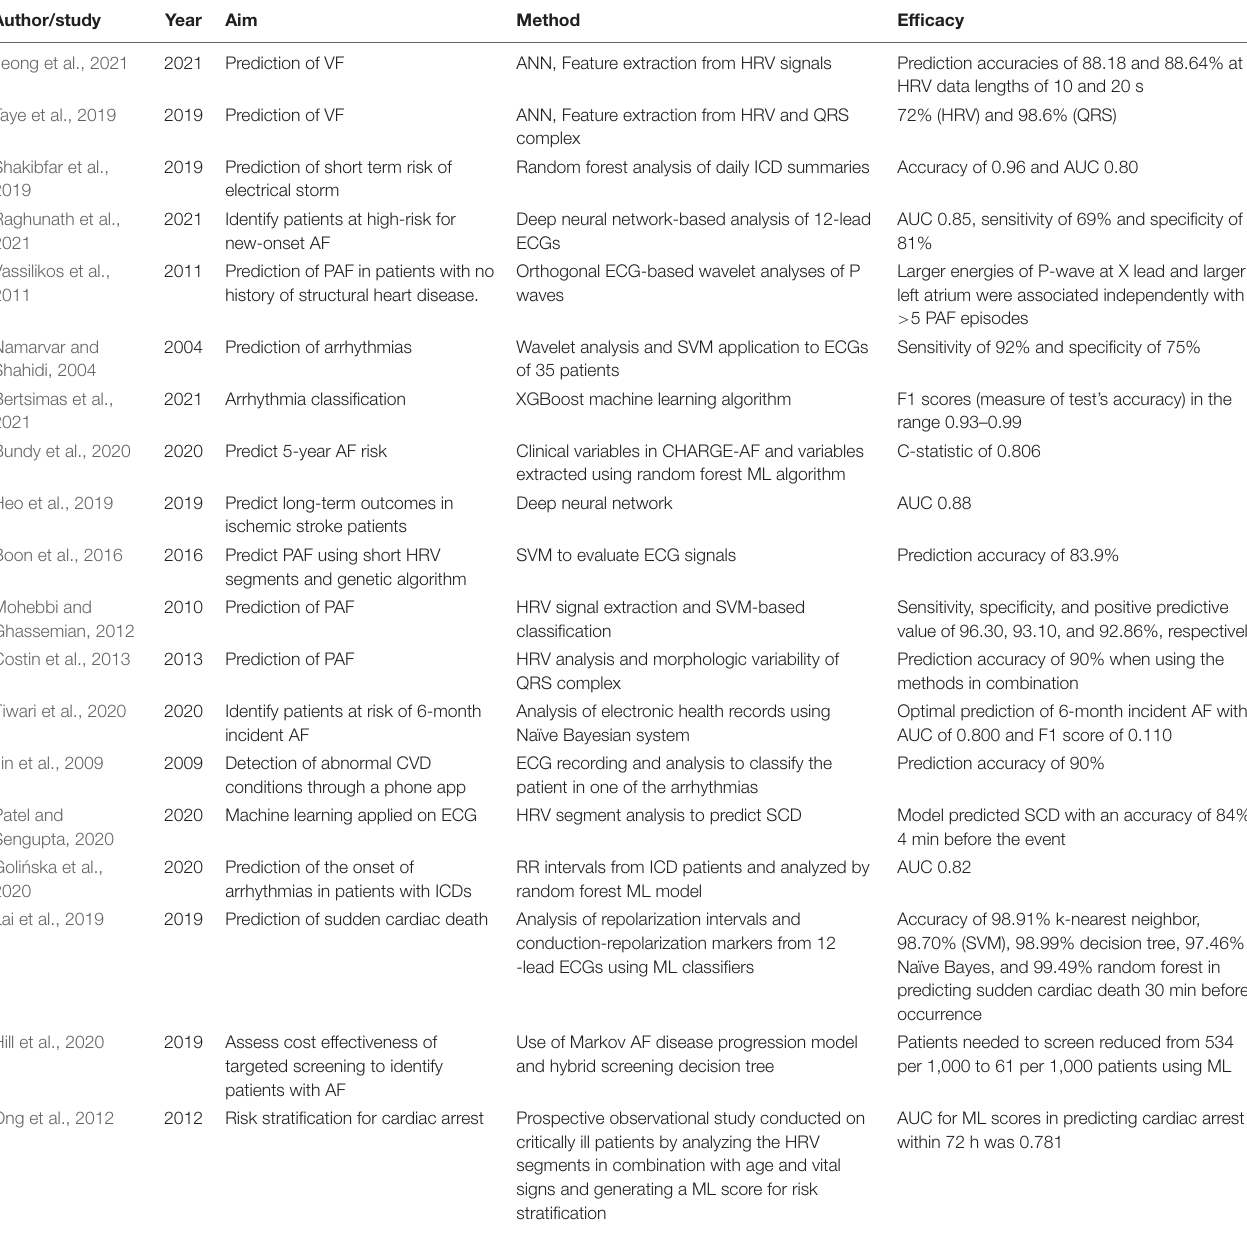
TABLE 1 | Prediction of cardiac arrhythmias: summary of recent non-linear dynamical and artificial intelligence (AI) algorithms for arrhythmia classification and